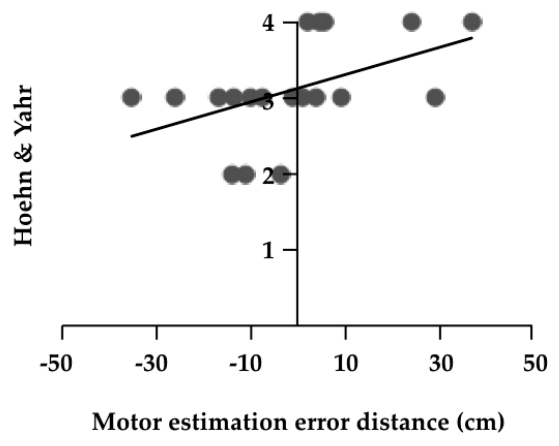
Figure 2. Correlation coefficient of the motor estimation error distance and Hoehn & Yahr stage.